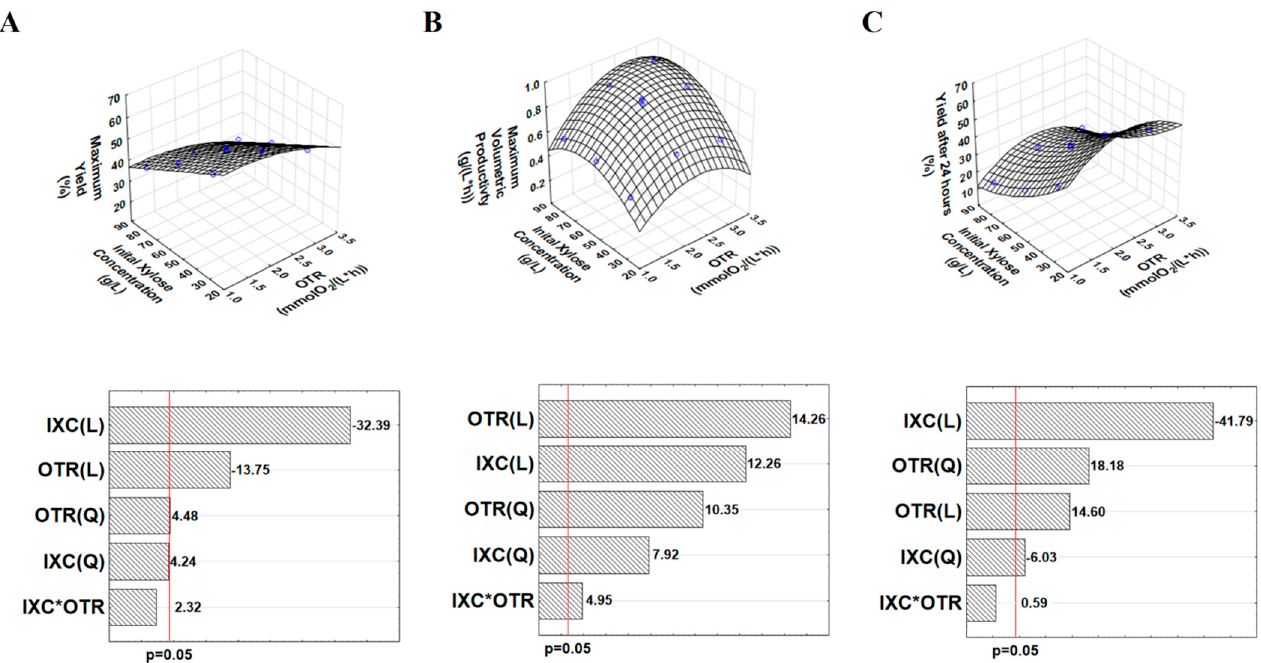
Figure 1. The fitted surface areas and Pareto charts of the evaluation of designed xylitol fermentation experiments using Candia boidinii NCAIM Y.01308. ( A ): maximum xylitol yield, ( B ): maximum xylitol volumetric productivity, ( C ): xylitol yield after 24 h. (OTR: oxygen transfer rate; IXC: initial xylose concentration).